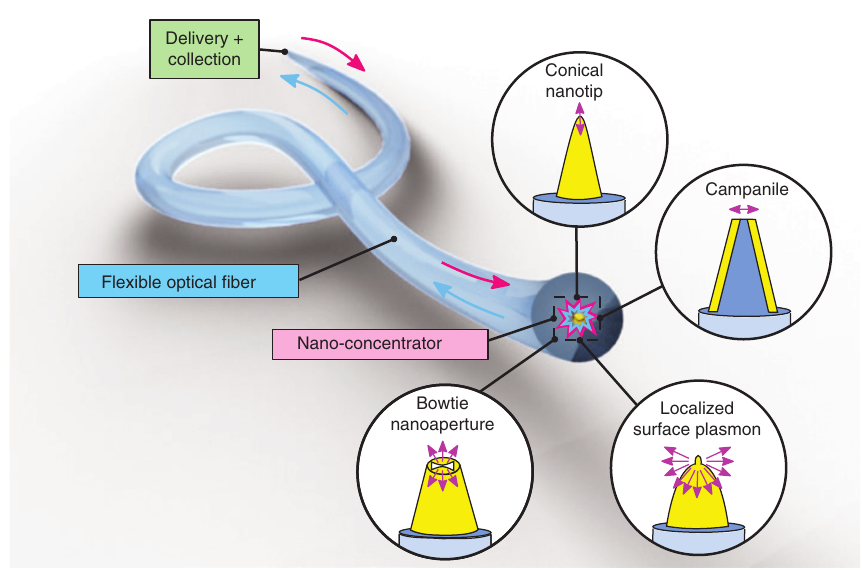
Figure 1: Nanoconcentration of light using flexible optical fibers interfacing with plasmonic nanoconcentrators at a fiber tip for the efficient delivery and collection of light to/from deep nanoscale dimensions.